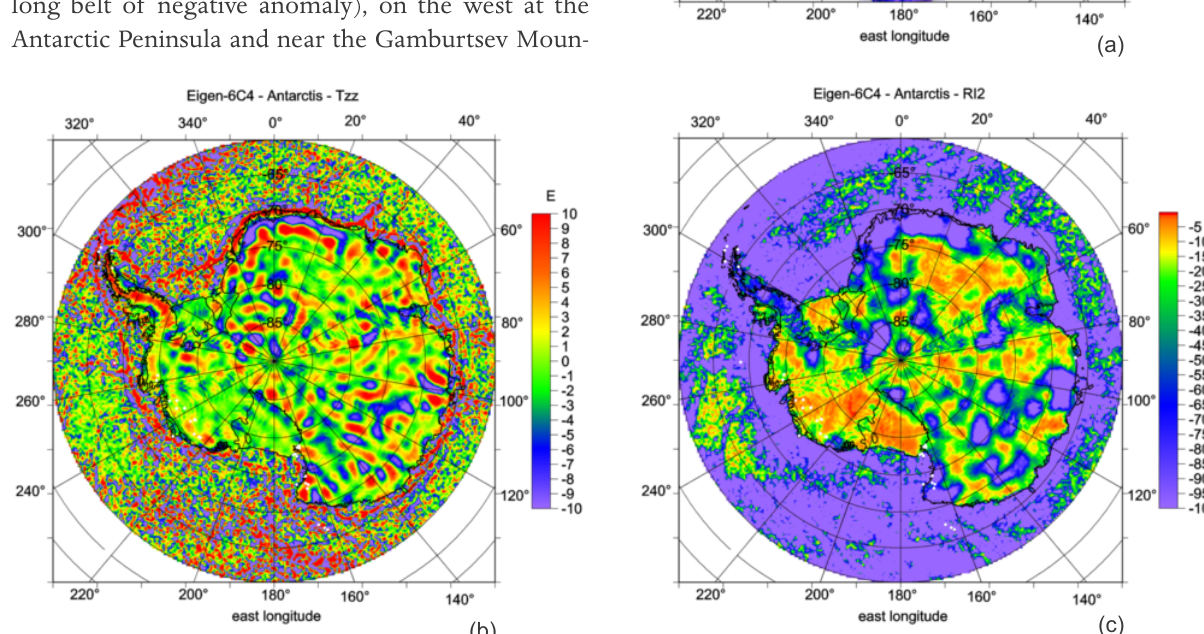
over Antarctica with complete EIGEN 6C4. White dots are for the largest known volcanoes in Figure 11. (a-b) The values of D g and T zz Antarctica, mostly near the sea shore or at islands near the continent. An extra map of known volcanoes was in Figure 1. The range of T over Antarctica is much larger than ±10 E, but here the scale is cut to emphasize various features. (c) The values of the invariant I tica with complete EIGEN 6C4. (Figure continues on next